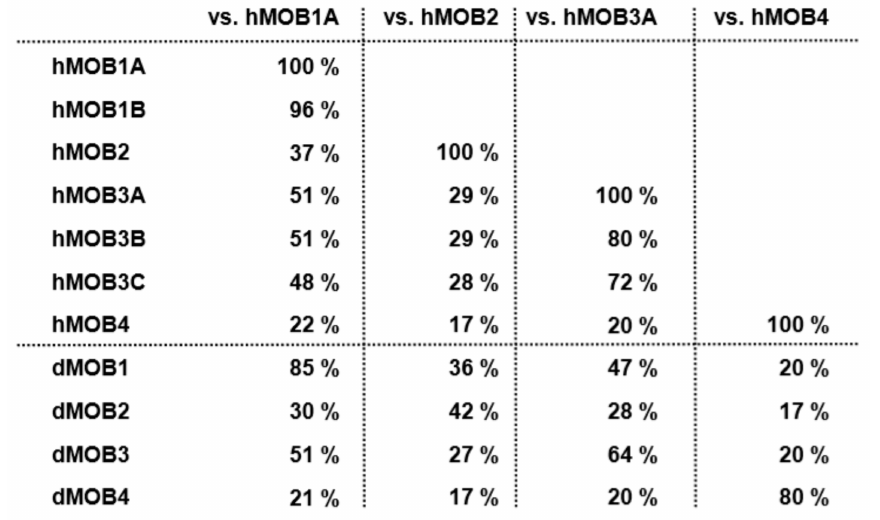
Figure 1. Primary sequence identities of the fly and human MOBs. The identities between primary sequences are displayed. Identities were defined using EMBOSS needle for pairwise alignments (https: // www.ebi.ac.uk / Tools / psa / emboss_needle / ). The UniProtKB nomenclature for hMOBs can be found in the introduction section of the main text. The UniProtKB names for dMOBs are as follows [4]: dMOB1 (aka Mats and CG13852)–Q95RA8, dMOB2 (aka CG11711)–Q8IQG1, dMOB3